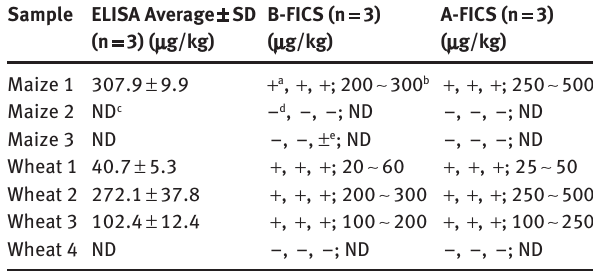
Chromatographic assay